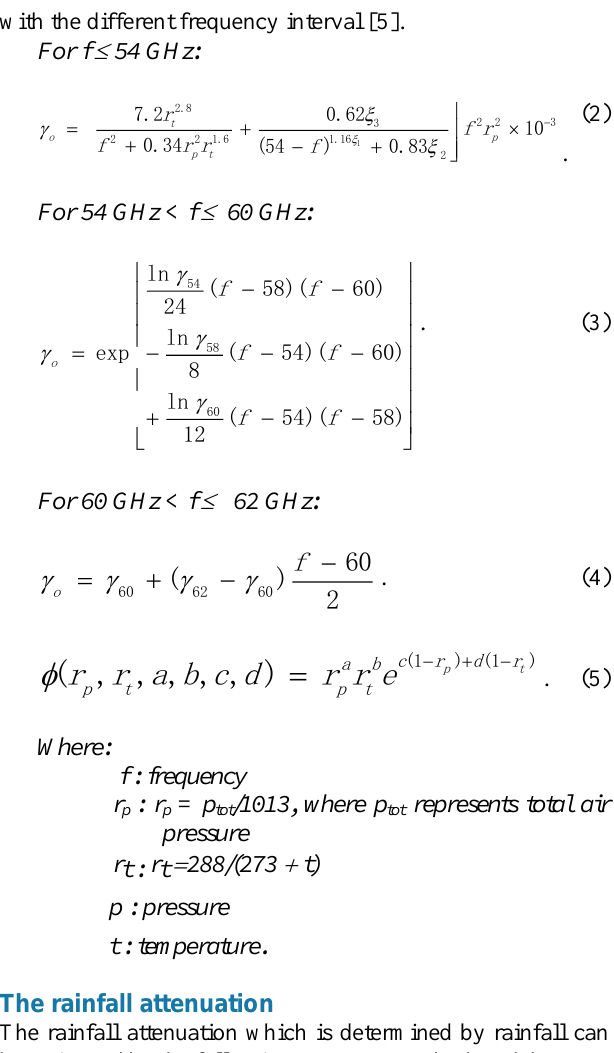
Figure 3. The view of the instance of the satellite-earth link